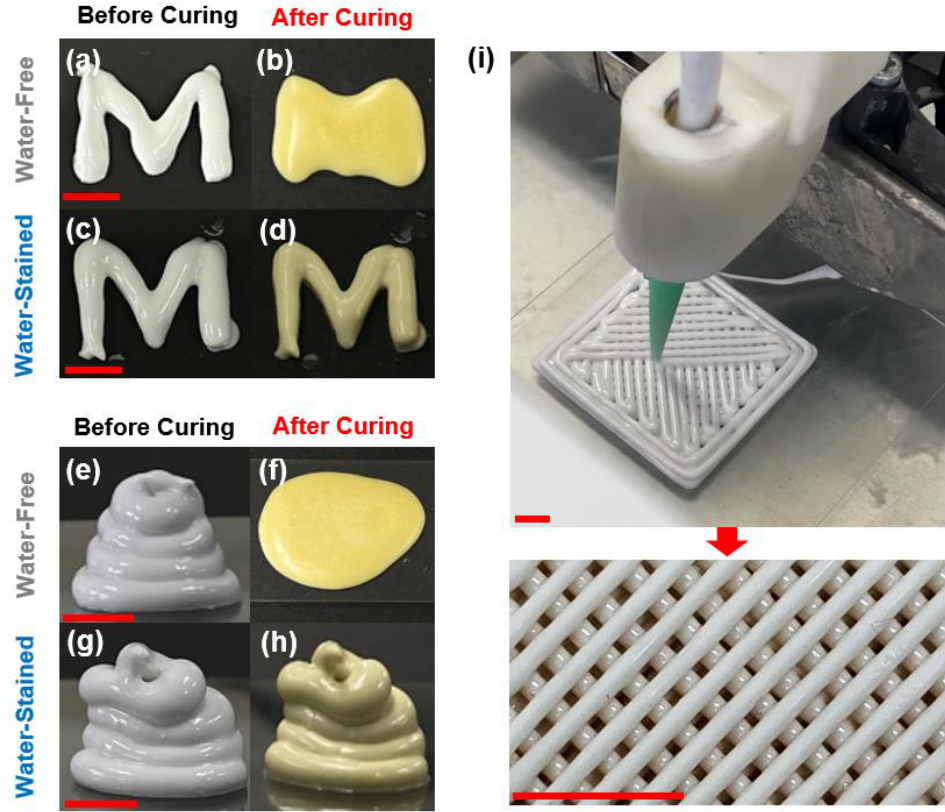
Figure 3. Photographs of hand-extruded letter “M” (( a – d )) and 3D architectures with arbitrary shapes (( e – h )), using water-free epoxy–alumina ink before ( a , e ) and after ( b , f ) thermal curing, and using water-stained ink before ( c , g ) and after ( d , h ) thermal curing. ( i ) Demonstration of instrument-assisted 3D printing using water-stained ink ( top ) and a magnified photograph of cured product ( bottom ). Fixed alumina concentration of 30 vol.% was used for all samples. For water-stained ink, a fixed water concentration of 3 vol.% was used. Red scale bars are 5 mm.